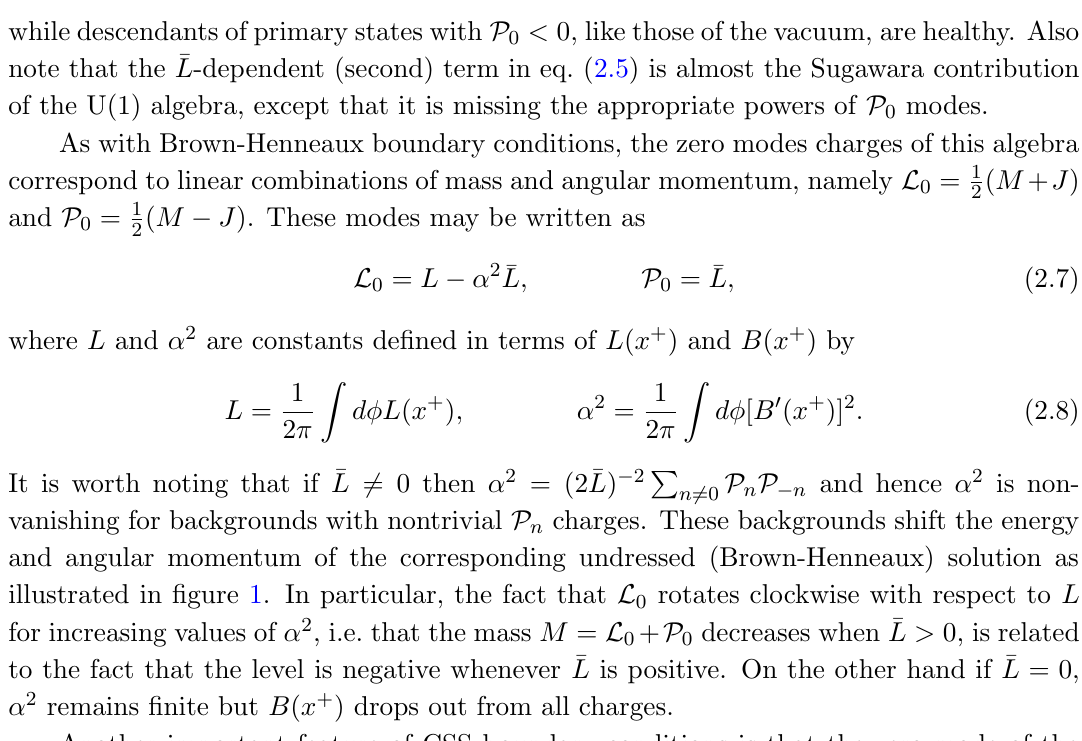
and denote the L 0 P 0 0, the axis approaches the L axis and ! L 0 < 0, like those of the vacuum, are healthy. Also P 0 P 0